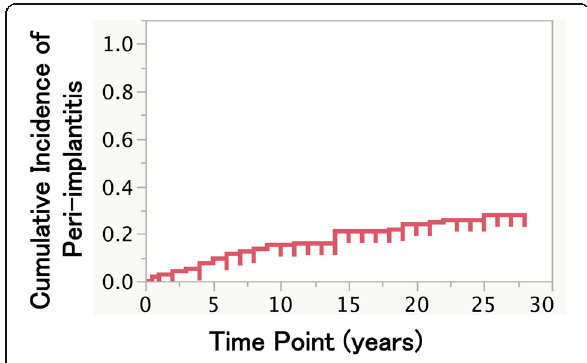
Fig. 3 Cumulative incidence of peri-implantitis